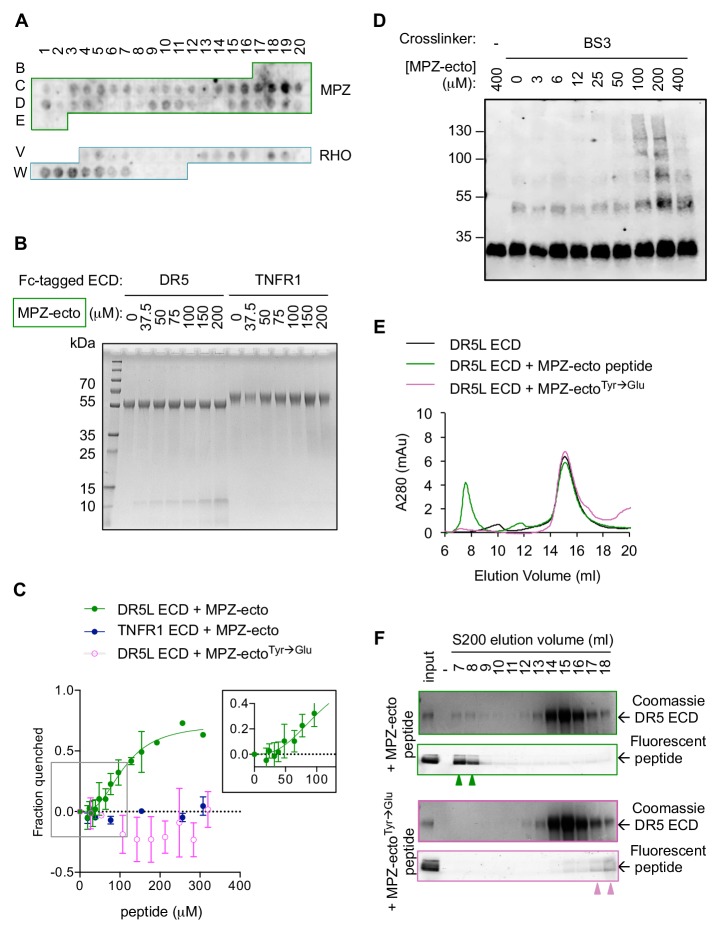
Direct binding of exposed ER-trafficked protein sequences to the DR5 ECD is sufficient to induce oligomerization.(A) A peptide array tiled with sequences from the ectodomain of myelin protein zero (MPZ) and extracellular loops from rhodopsin (RHO) was incubated with Fc-tagged DR5 ectodomain domain (long isoform, 500 nM). Signal was obtained by probing with anti-Fc. (B) Coomassie stained SDS-PAGE gel of pulldown on Fc-tagged DR5L ECD (55 kDa) or TNFR1 ECD (65 kDa) incubated with increasing concentrations of the MPZ-ectoVD peptide (apparent MW of 10 kDa, see 'Amino acid sequences of MPZ-derived peptides' for sequence). (C) Fluorescence quenching of AlexaFluor647-DR5L (green) or TNFR1 ECD (blue) was measured with increasing MPZ-ecto peptide to quantify the binding affinity, whereas quenching was not observed with the mutated MPZ-ectoTyr→Glu peptide (magenta) (N = 3, error bars are SD). DR5L ECD binds to the MPZ-ecto peptide with a K1/2 of 109 ± 11 μM with a hill coefficient of 2.6 ± 0.5. (D) SDS-PAGE of recombinant FLAG-tagged DR5L ECD (25 kDa, 10 μM) incubated with MPZ-ecto peptide at the noted concentrations and treated with the amine crosslinker BS3 (100 μM), probed with anti-FLAG. (E) Size exclusion chromatographs of absorbance at 280 nm for 25 μM recombinant DR5L ECD alone (black), pre-incubated with 100 μM fluorescein-conjugated MPZ-ecto peptide (green) or 100 μM fluorescein-conjugated MPZ-ectoTyr→Glu peptide (magenta). (F) SDS-PAGE gels scanned for fluorescence and then stained with Coomassie for eluted size exclusion fractions in (E). Green outlines (top pair) correspond to fractions from DR5L pre-incubated with MPZ-ecto peptide, and magenta outlines (bottom pair) correspond to DR5L with MPZ-ectoTyr→Glu peptide. Lane marked by “-“ denotes a blank lane between the input and 7 ml fraction to minimize spillover of signal from input sample. Arrowheads mark detectable peptide fluorescence in the indicated fractions.Figure 3—source data 1.Sequences and quantification of peptides probed with Fc-DR5 ECD on the peptide array.This excel file contains the peptide sequences of the peptide array shown in Figure 3A, the quantification of DR5 ECD detected for each spot, and the analysis for enriched amino acids in Figure 3—figure supplement 1.